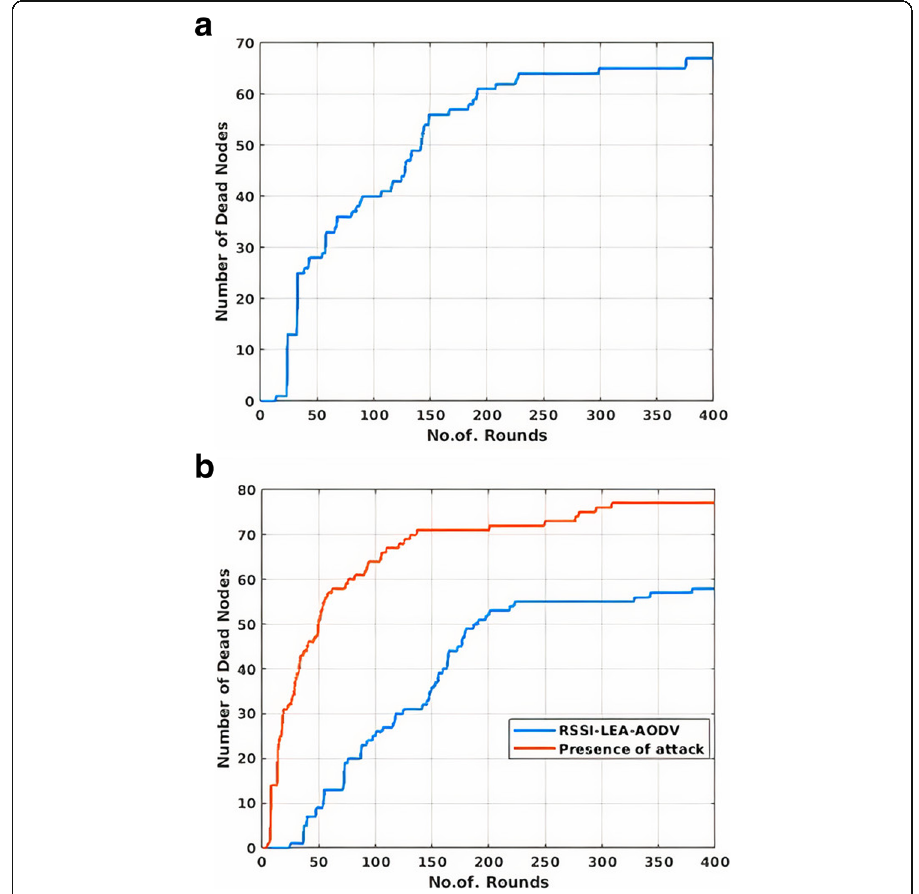
Fig. 11 a Dead nodes in the network without a Sybil attack. b Performance comparison of dead